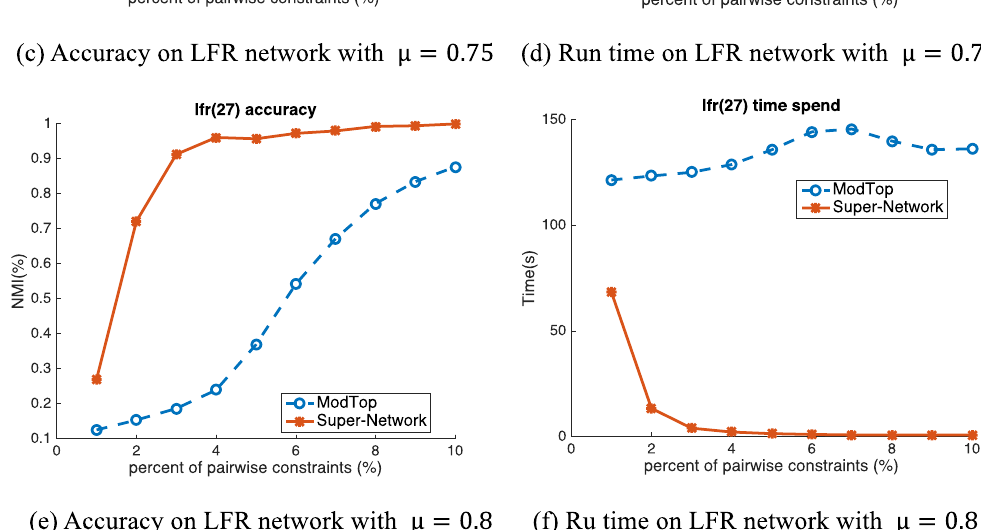
original network with Z out = 8 and 5% pairwise constraints as an example, time spent on Super-Network (0.28 s) is almost 10 times smaller than ModTop (2.86 s). This illustrates the high efficiency and speed of our proposed Super-Network. LFR network has a larger structure with more nodes and a topology more complex than GN network, there- fore the improvement of accuracy and speed on LFR will be more convincing compared with that on GN. In Figs 4 and 5, we show the performance on LFR network using NMF and modularity maximization with spectral optimization, respectively. In each figure, the three rows are the results on network with μ = 0.7, 0.75 and 0.8, respectively. All of the results illustrate consistent improvement on both accuracy and speed get higher perfor- mance upon Super-Network compared to ModTop, especially on speed. For example, on network with μ = 0.75,